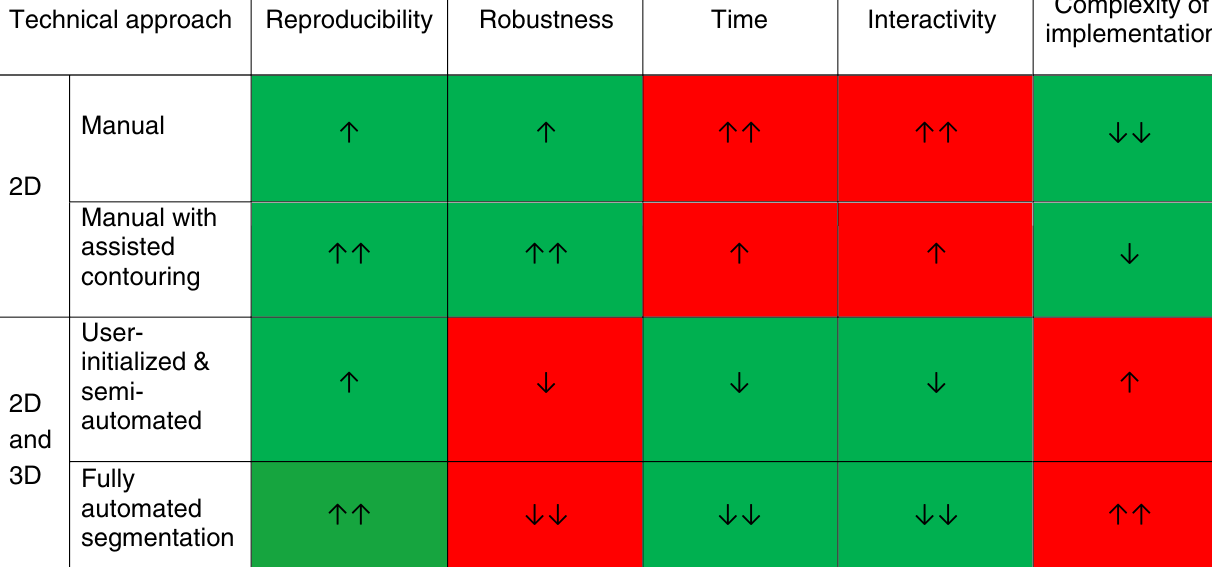
Summary of advantages and limitations of various segmentation methods [13] Technical